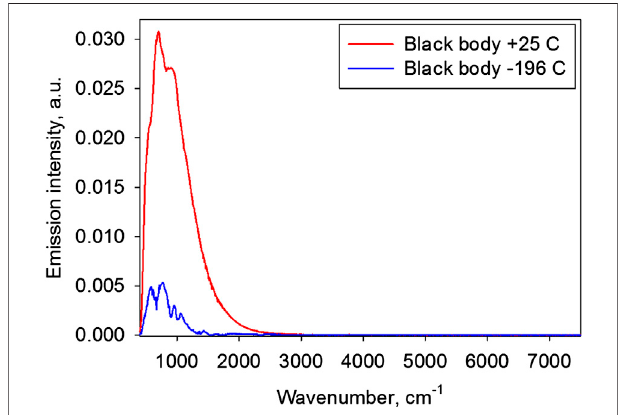
FIGURE 4 | The black body emission spectra at 25 and − 196 ° S .